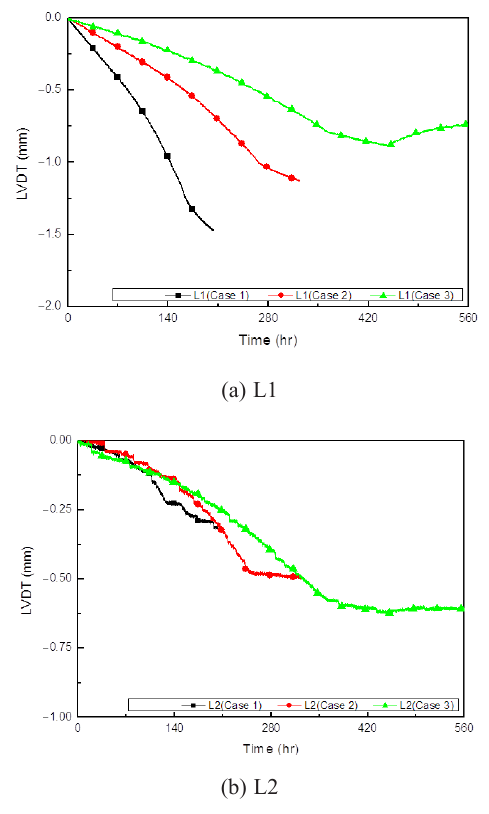
Fig. 6. Time histories of vertical displacement at rear side of levee (after 62.5